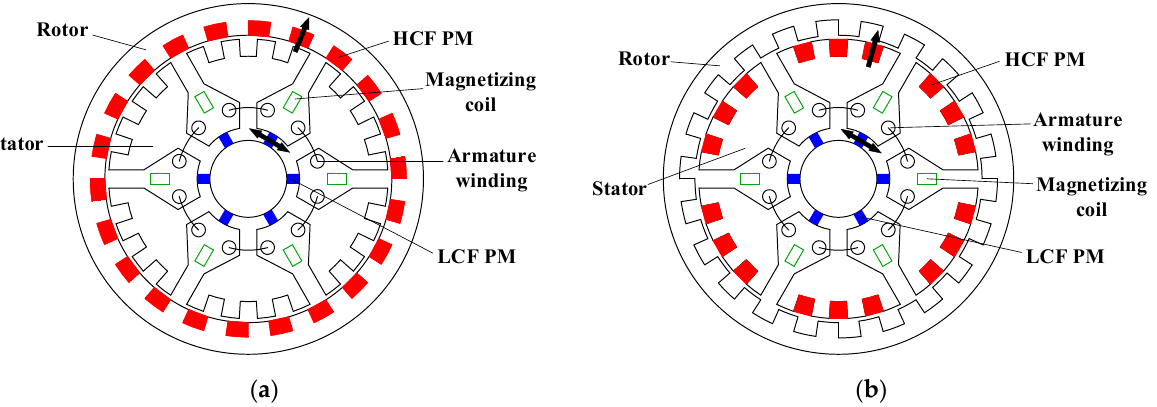
Figure 39. Two types of hybrid PM VFM machines with LCF PM on stator [102] . ( a ) Type ‐ 1 (HCF PM on rotor). ( b ) Type ‐ 2 (HCF PM on stator).